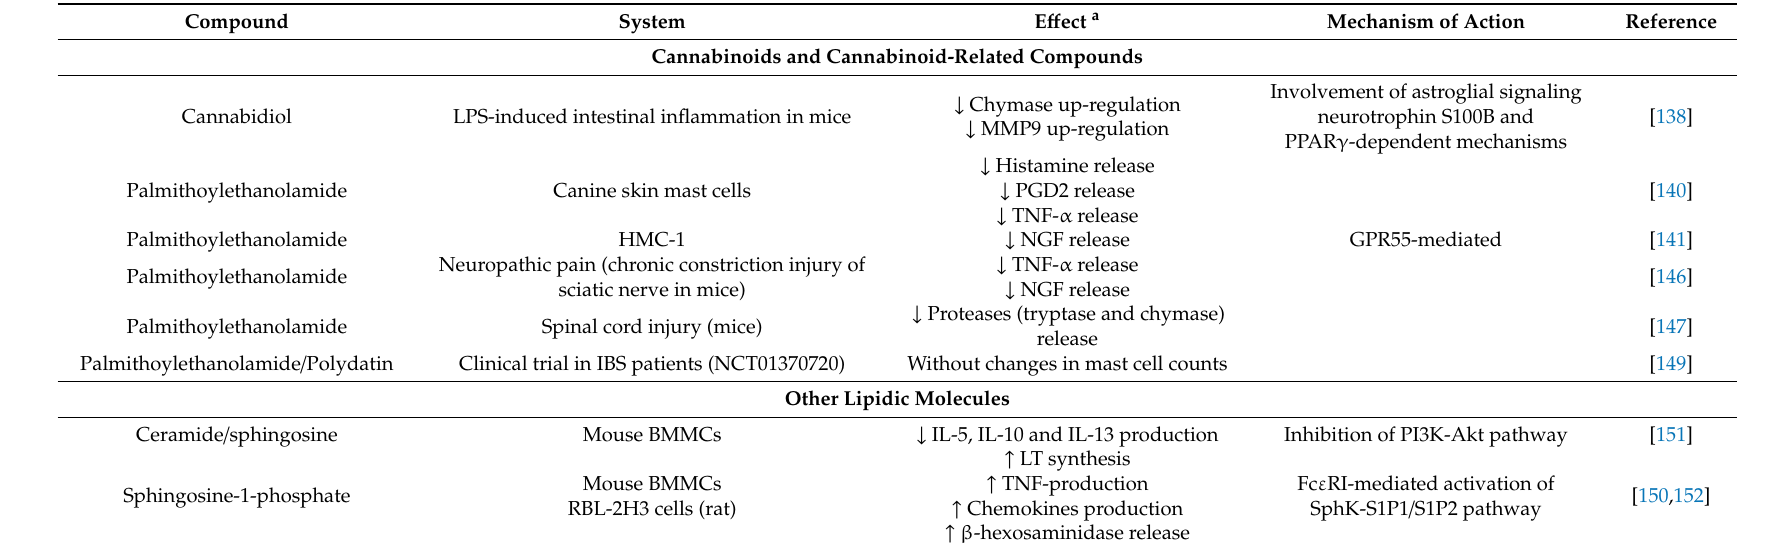
Table 3. Immunomodulatory e ff ects of cannabinoids, cannabinoid-related compounds and other lipidic molecules on mast cell